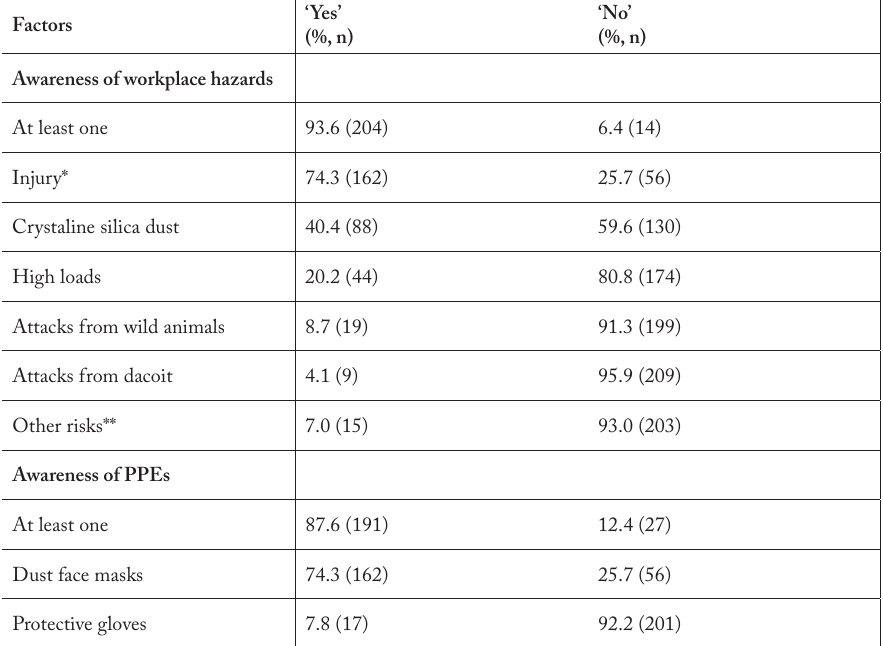
Table 2. Awareness of workplace hazards and PPEs and use of PPEs among mine workers from block ‘Karauli’, Karauli district, Rajasthan, India ( n =